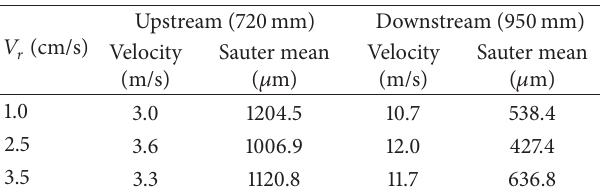
Table 3: Averages of the droplet velocity and size near the blockage